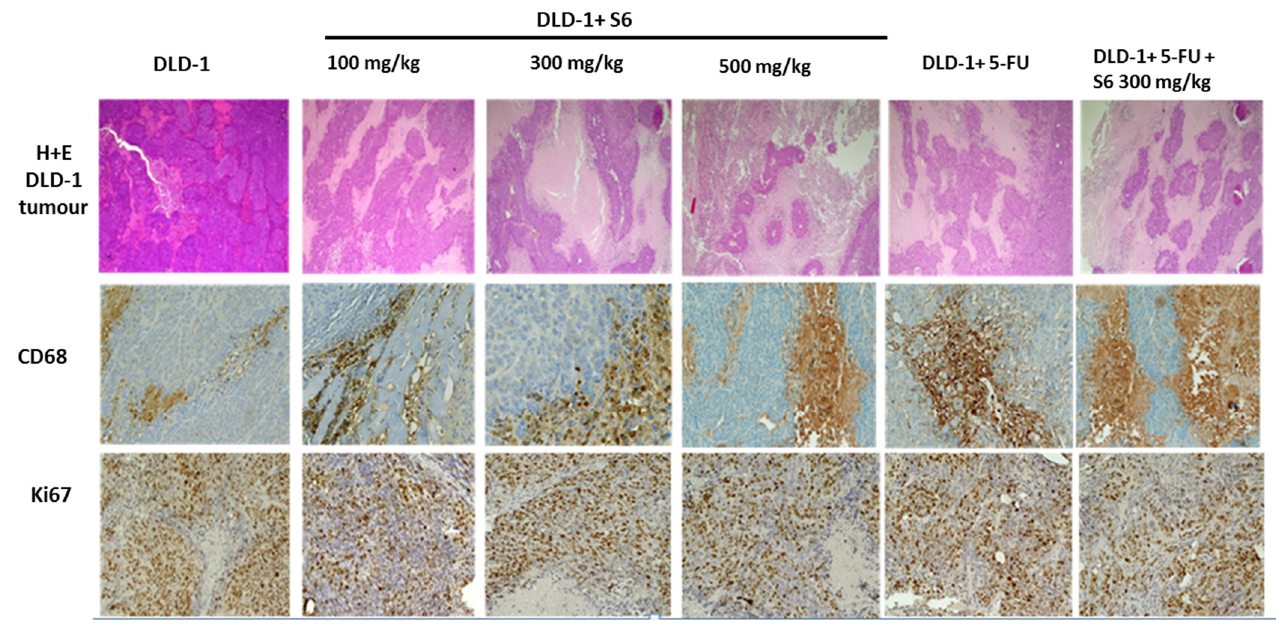
Figure 6. H&E staining, CD68, and Ki67 immunohistochemical expressions for DLD-1 tumor (200× magnification) .